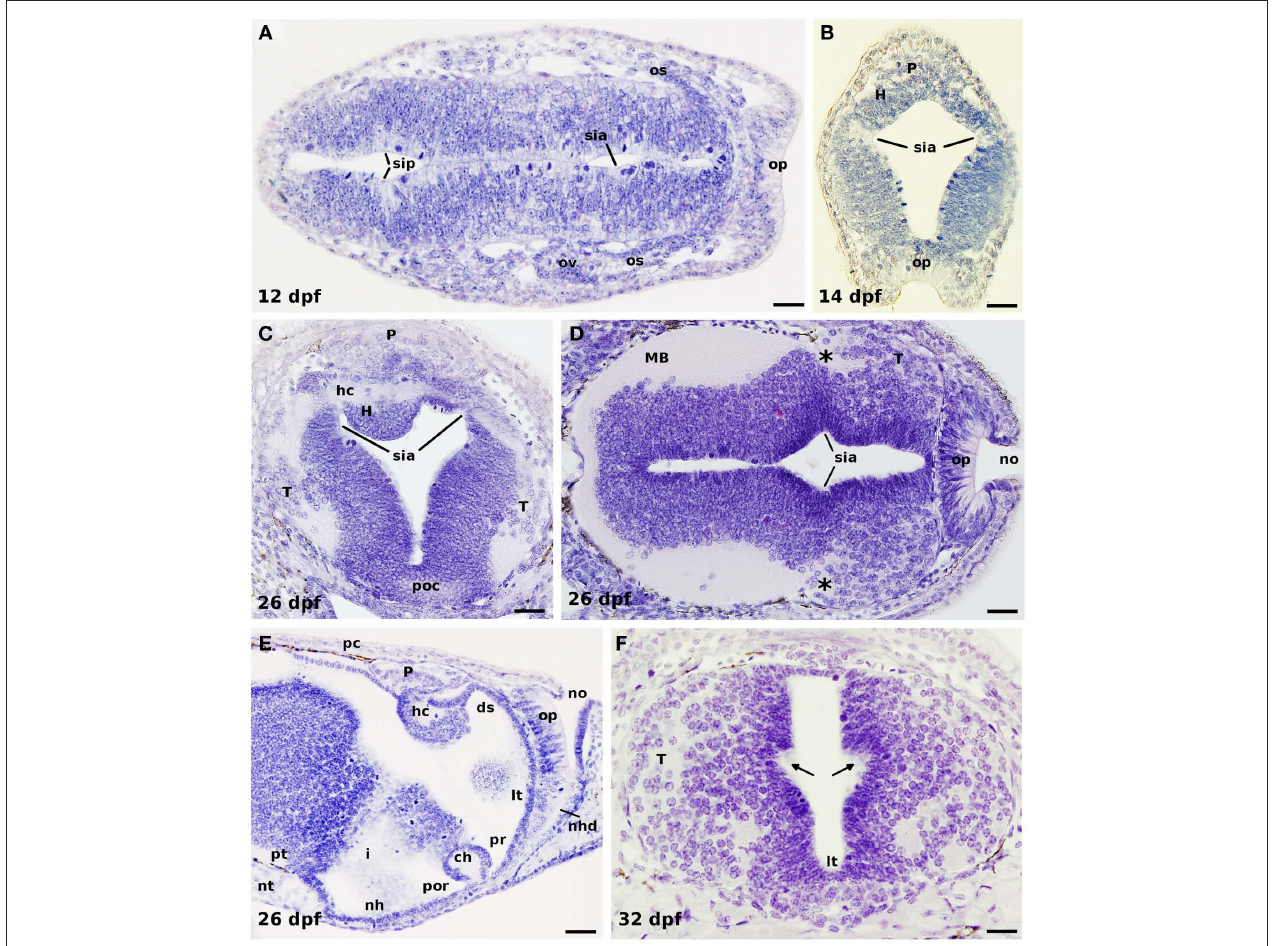
(e) Sagittal section of a 26-dpf prolarvae showing the midline prosencephalic structures. (F) Section through the telencephalon of a late prolarvae showing at both sides the incipient anlage of the interventricular foramen (arrows). In ( A,D,e) rostral is to the right. ds, dorsal sac; H, habenula; hc, habenular commissure; i, infundibulum; lt, lamina terminalis; MB, midbrain; nh, neurohypophysis; nhd, nasohypophyseal duct; no, nasal opening; nt, notochord; os, optic stalk; ov, optic vesicle; op, olfactory placode; P, pineal organ; pc, posterior commissure; poc, postoptic commissure; por, postoptic recess; pr, preoptic recess; pt, posterior tuberculum; sia, sulcus intraencephalicus anterioris; sip, sulcus intraencephalicus posterioris;